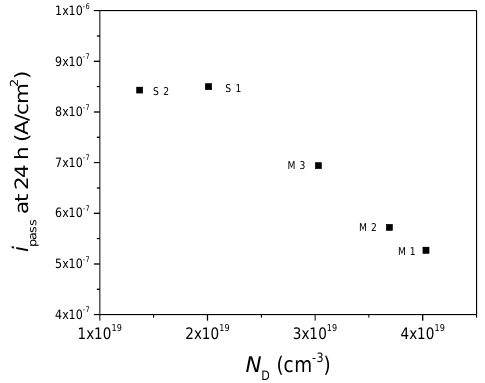
Figure 11. Relationship between donor density and steady state passive current density.